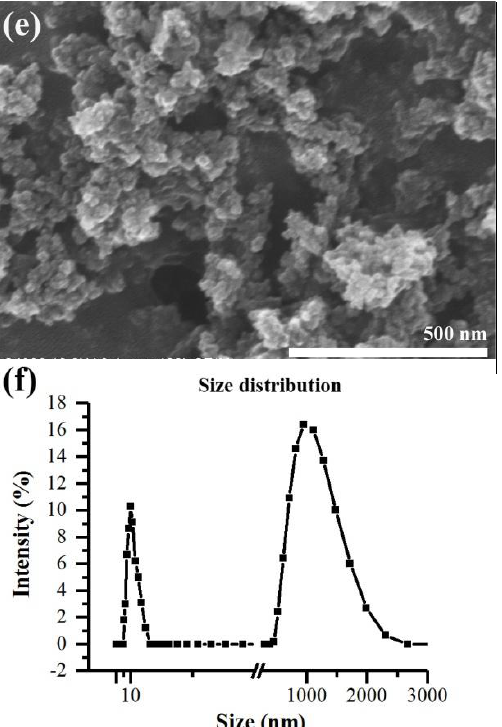
Figure 2. SEM images and size distribution of PDVB-NP S with different mass ratios of DVB and AINB: ( a,b ) P 40 , ( c,d ) P 4 , and ( e,f ) P 0.4 .